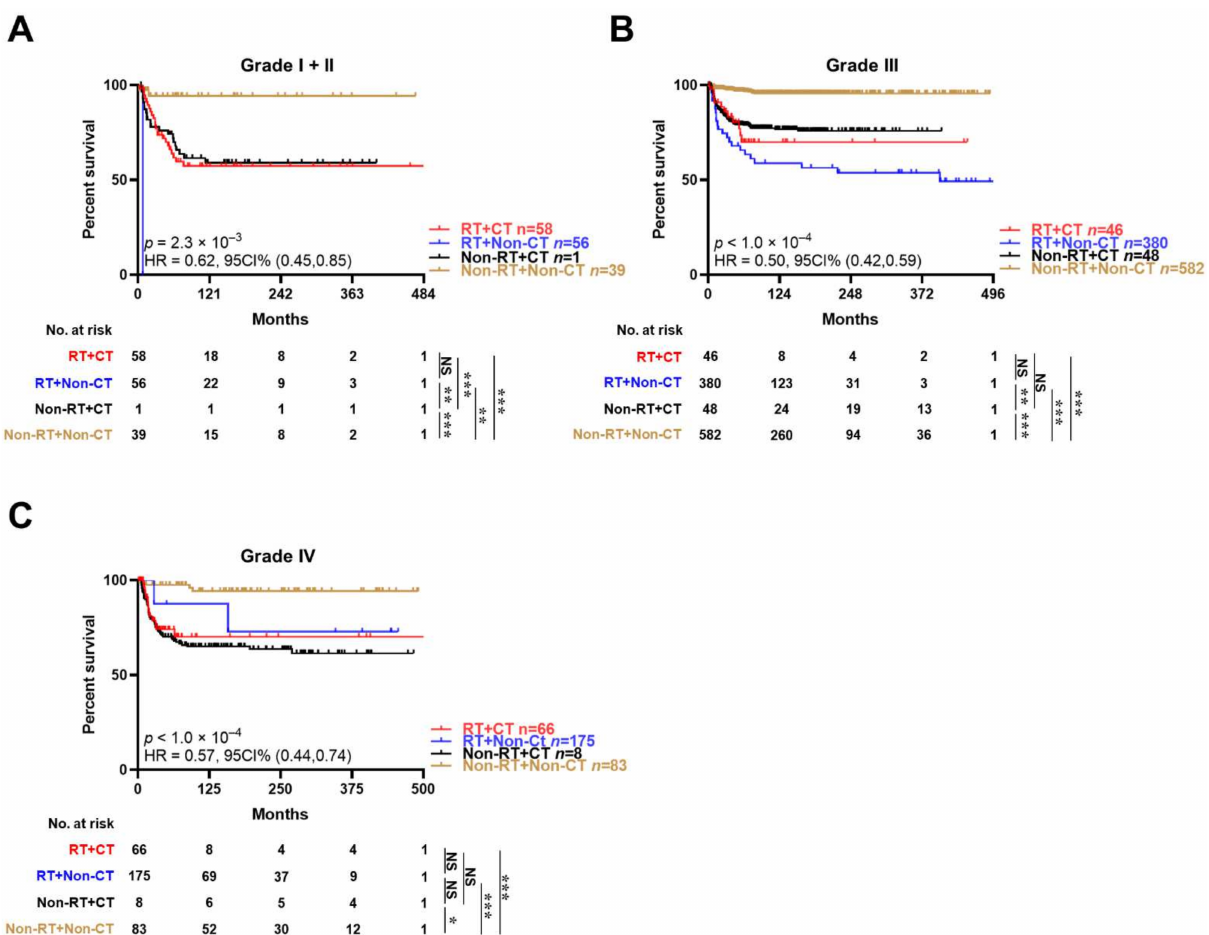
Figure 3. Effects of combinatorial therapies on the long-term survival of neuroblastoma patients receiving surgery, with tumors of different histopathological grades in unmatched data. ( A ) Patients with both grade I and grade II tumors; ( B ) Patients with grade III tumors; ( C ) Patients with grade IV tumors. Kaplan–Meier curves reflecting the disease-specific survival of patients who underwent the indicated treatment. CT, chemotherapy; RT, radiotherapy. Log-rank test for survival comparison in ( A – C ). * p < 0.05, ** p < 0.01, *** p < 0.001. NS,